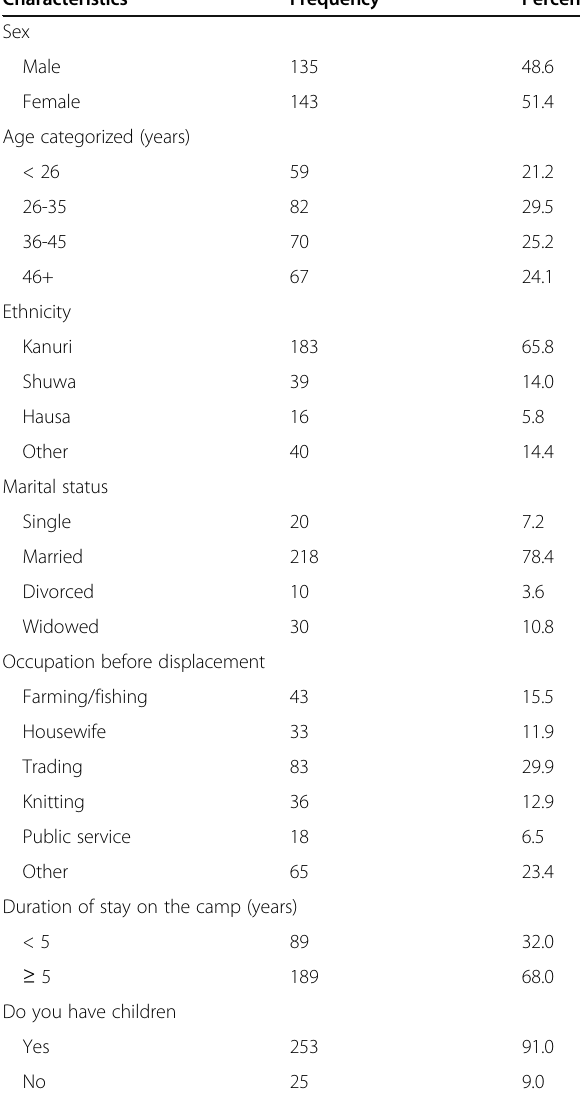
Table 1 Socio-demographic characteristics of respondents of IDP Camps Respondents in Borno